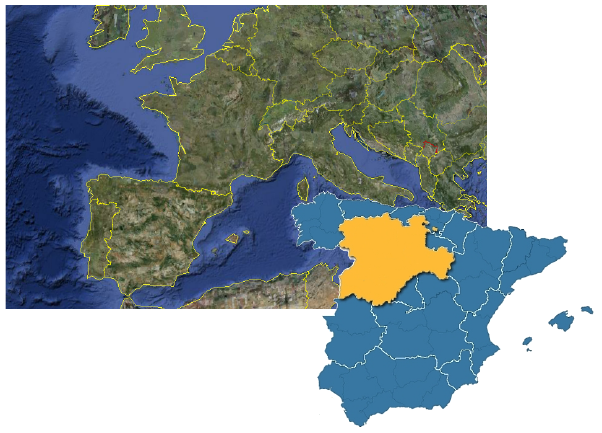
Fig. 1. Geographic location of Castile and Leon.